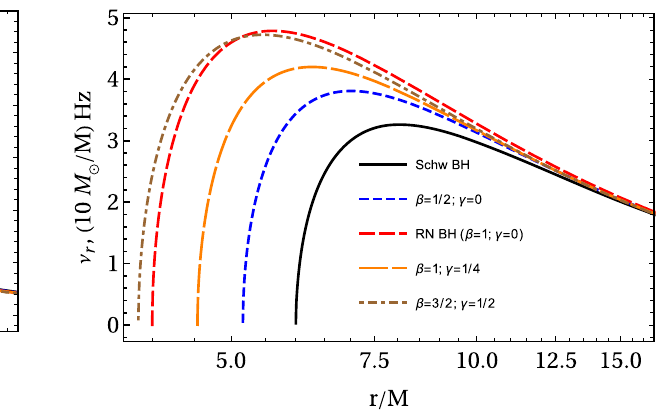
Fig. 10 Keplerian frequency of test particles around charges BHs in EMS gravity as a function of the radial coordinate for various values of the EMS parameters β and γ and BH charge is taken as Q = M except Schw BH